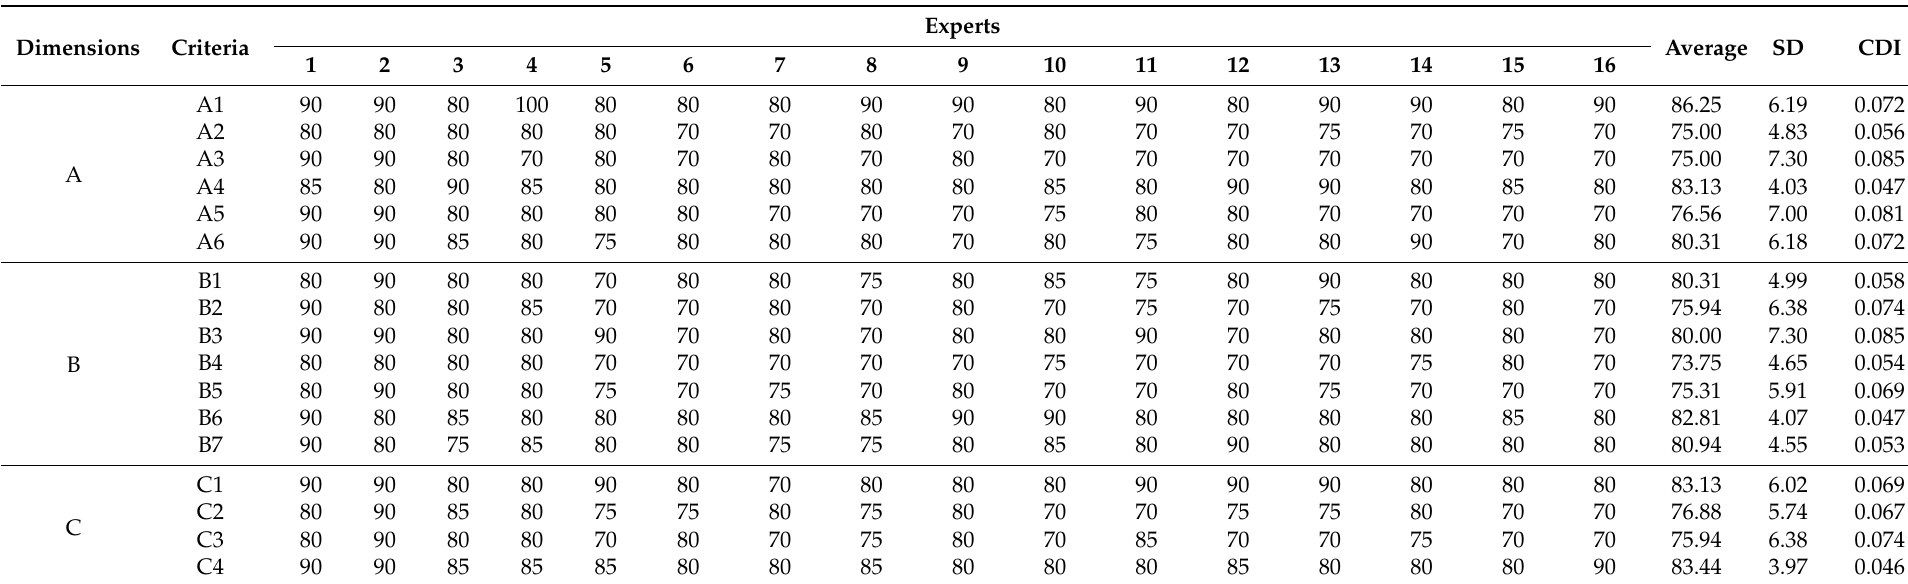
Table 13. Second-round Rating on the Necessity of